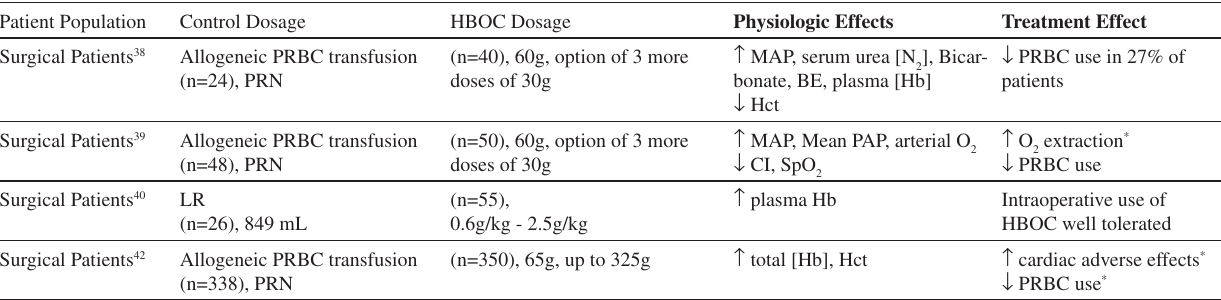
Table 4 - Hemopure clinical trials Patient Population Control Dosage HBOC Dosage Physiologic Effects Treatment Effect Surgical Patients